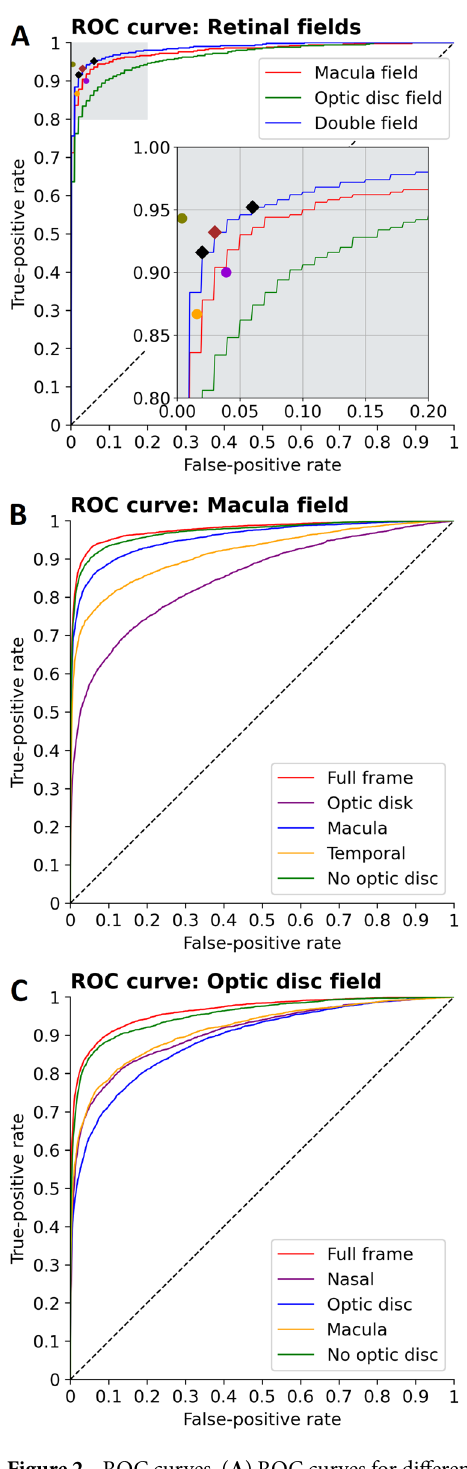
Figure 2. ROC curves. ( A ) ROC curves for different field inputs. Close up shows operating points (red: Youden’s index OP, black diamonds: high sensitivity and high specificity OPs) and intergrader values (purple: primary vs. secondary, orange: primary, green: secondary) depicted. ( B ) ROC curves illustrating algorithm performance based on different input regions from the macula field. ( C ) ROC curves illustrating algorithm performance based on different input regions from the optic disc